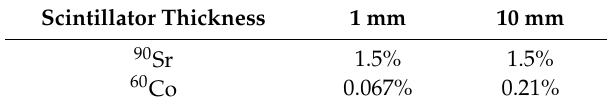
Figure 30. Multi-sensitive (MS) and tritium (TR) screens [96–99]. Table 15. Radiation detection efficiency with source and scintillator thickness.